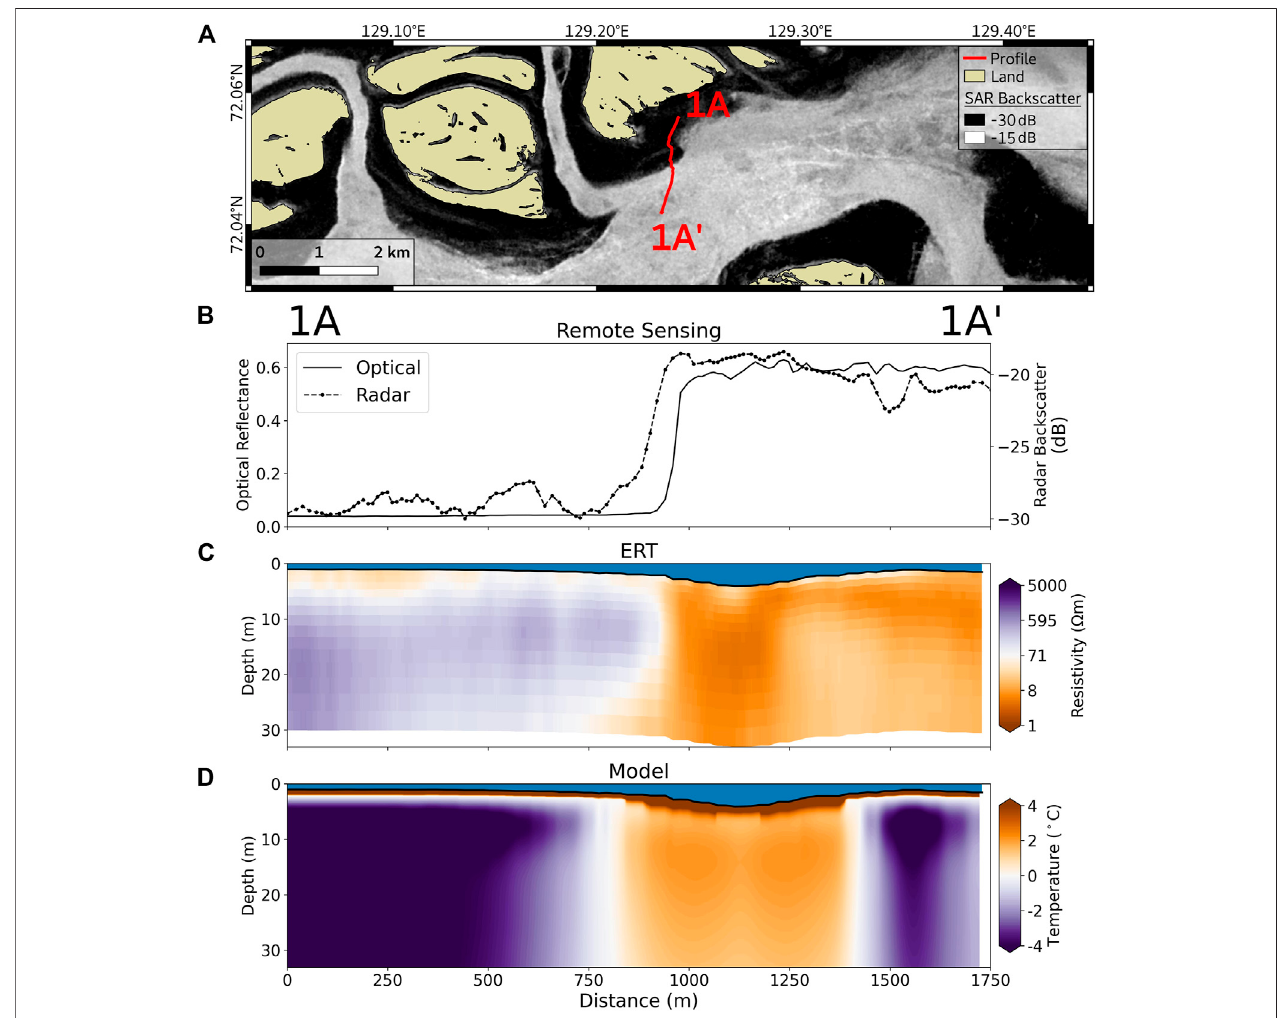
FIGURE4| Pro fi le (1A – 1A ’ ) (forthelocationsee Figure1 ). (A) GPStrackoftheERTpro fi leontopoftheSARSentinel-1medianwinterimageshowingthebedfast (dark)andserpentine(bright)ice. (B) Extractedopticalre fl ectanceandSARbackscatteralongthepro fi le. (C) CrosssectionoftheinvertedERTresistivityalongthepro fi le. (D) Modeled sediment temperature along the pro fi